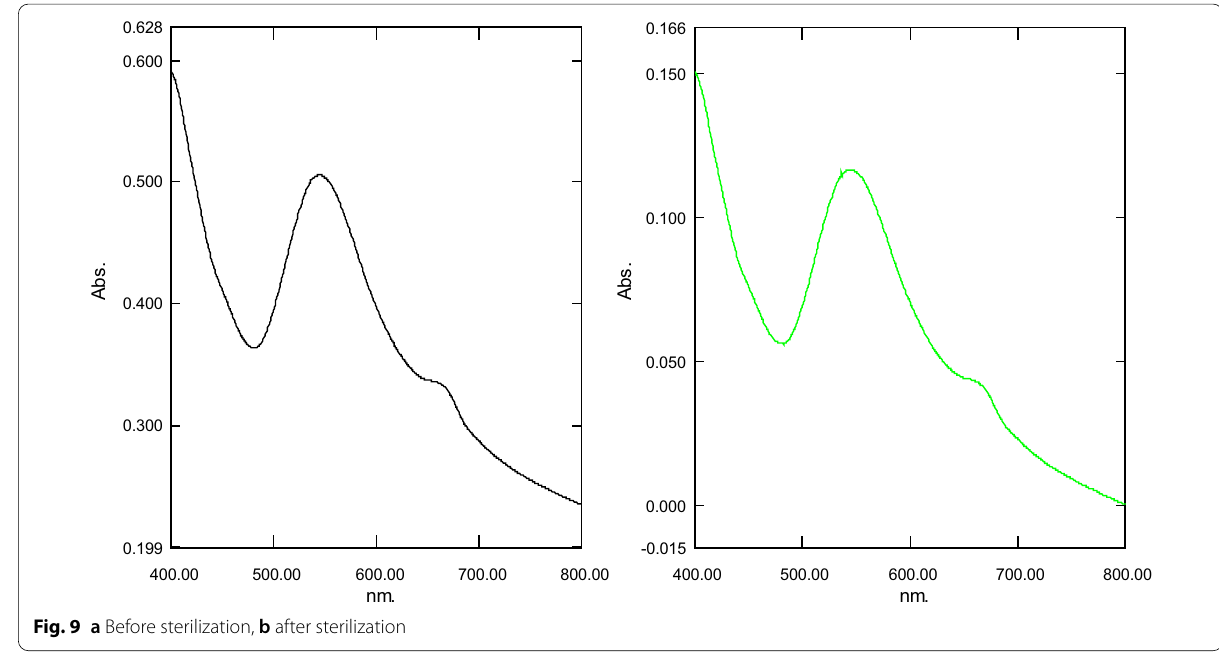
0.450.50.550.6 Fig.10 Representation graph of in vitro stability of nanoparticles